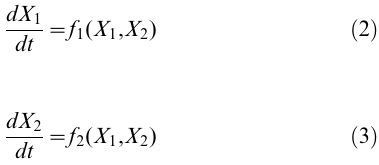
per capita and Democracy for the year 2006. The Pearson correlation coefficient between the two variables is 0.571 (p , 0.01).